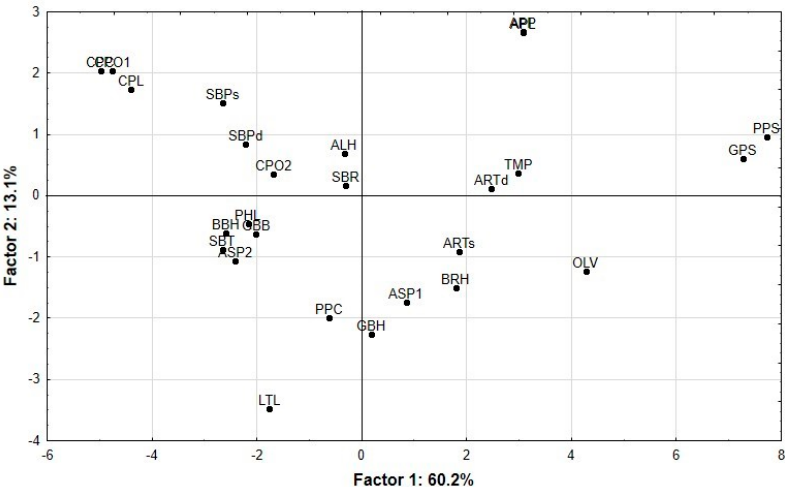
Figure 2. Principal component analysis showing the grouping and separation of the by-products based on chemical composition, in vitro digestibility and fermentation kinetics: OLV (olive tree leaves), PPS (pepper skins), GPS (grape seeds), ARTd (hay of artichoke by-products), GBH (green bean haulms), ASP1 (asparagus rinds 1), BRH (broccoli stalk hay), ARTs (ensiled artichoke by-products), TMP (dried tomato pulp), APP (apple and pear pomace), APL (apple pomace), LTC (lettuce leaves), PPC (pepper cores), ALH (almond hulls), GBB (green bean haulms and sugar beet pulp), SBR (sugar beet rootlets, hairs, root tips and beet tails), PHL (pea haulms), BBH (broad bean haulms), ASP2 (asparagus rinds 2), SBT (sugar beet tops and leaves), CPC (clementine pulp), CPO2 (orange pulp 2), CPL (lemon pulp), CPO1 (orange pulp 1), SBPd (sugar beet pulp dehydrated) and SBPs (ensiled sugar beet